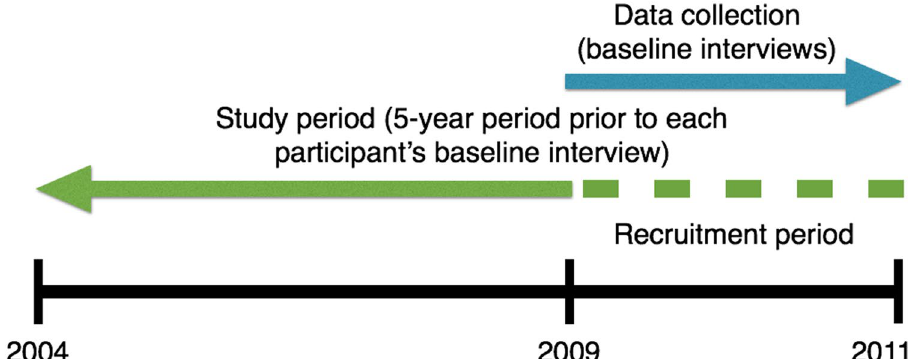
Figure 1. Study timeline. The green dashed line signifies the period during which participants were recruited and which in turn defines the end point of the five-year pre-baseline study